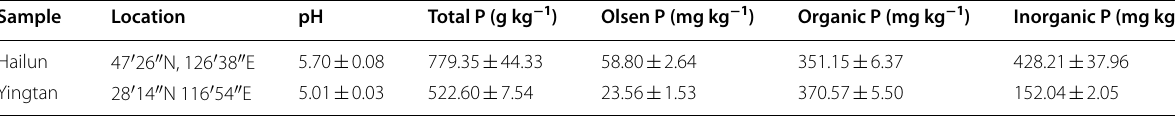
Table 1 Basic information and soil properties of the two soil samples